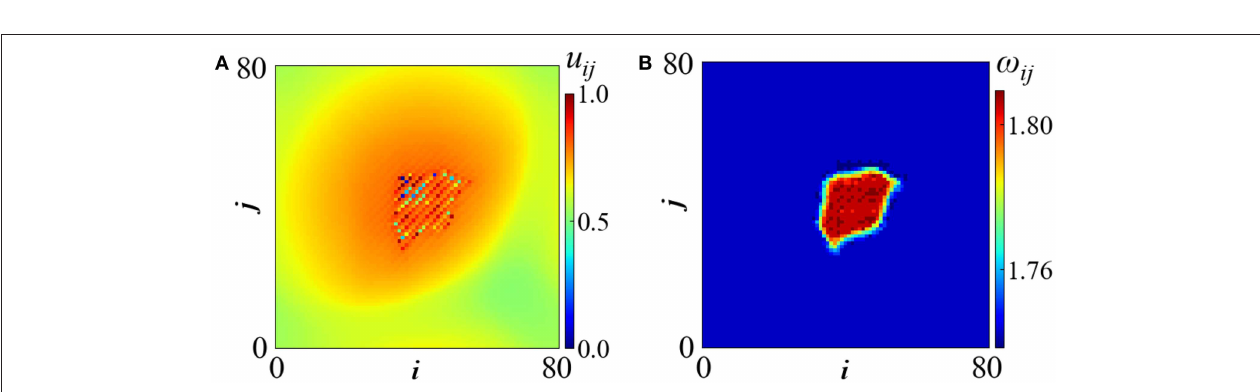
FIGURE 5 | Chimera state with slanted fractal deterministic connectivity: (A) u ij -profile and (B) ω ij -profile. Parameters are σ = 0.2 and T r = 0.1. All other parameters are as in Figure 2A . Simulations start from random initial conditions.